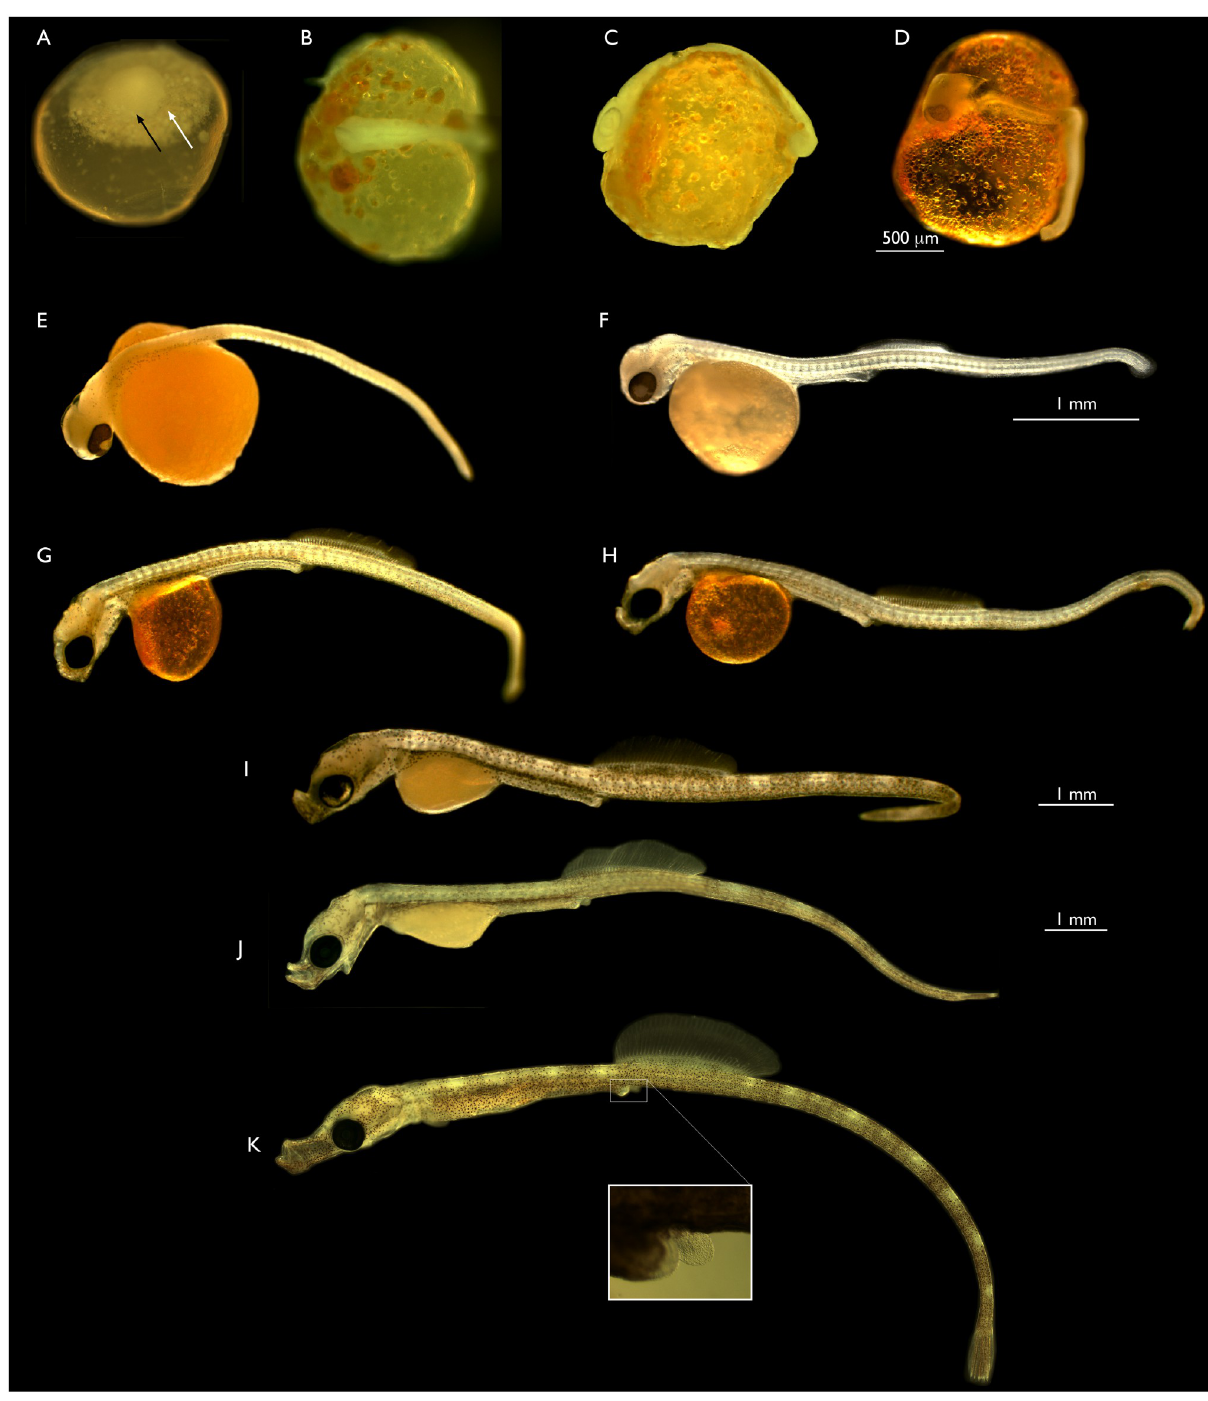
Fig 1. Embryonic development of the bay pipefish. A. Blastula/disc stage. The black arrow indicates the lateral border of the dense disc of cells. The white arrow indicates a larger disc of more dispersed material that the cellular disc sites upon. Approximate equivalent; medaka stage 11–12. B. Early segmentation stage. Anterior end of embryo is to the left. Approximate medaka stage 18–19. C. Late segmentation stage, lateral view. Retina obvious. Approximate medaka stage equivalent is stage 22. D. Early pharyngula stage. Retina obvious, extensive somitogenesis. Posterior tail is not attached to yolk sac. Approximate equivalent; medaka stage 25, except the tail is longer and detached in the pipefish. E. Mid-pharyngula stage. No snout, no fin blastemas. F. Mid pharyngula stage II. Slight protuberance in future snout region (white arrow). Dorsal and caudal fin blastemas present, first dorsal fin rays are emerging, no rays in caudal fin. G. Late pharyngula stage. Future snout small. Dorsal fin rays still forming, first rays in caudal fin are apparent. H. Late pharyngula stage. Future snout small. Dorsal fin rays still forming, first rays in caudal fin are apparent. I. Early hatching stage. Snout distinct, jaw